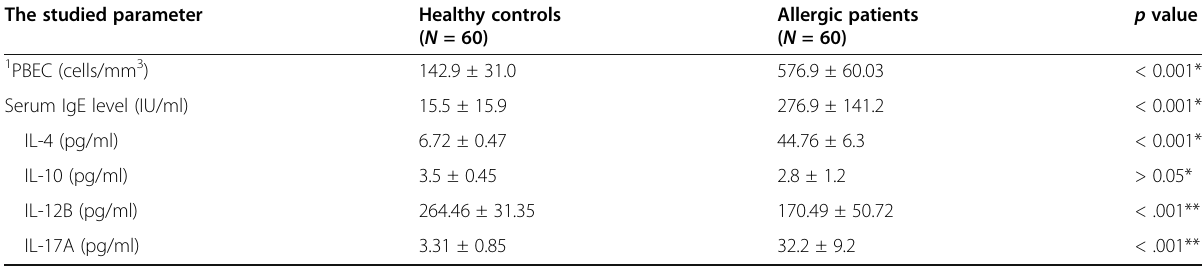
Table 4 Comparison between dust mites' allergic patients and controls regarding laboratory data (IgE levels, eosinophilic count, and interleukins